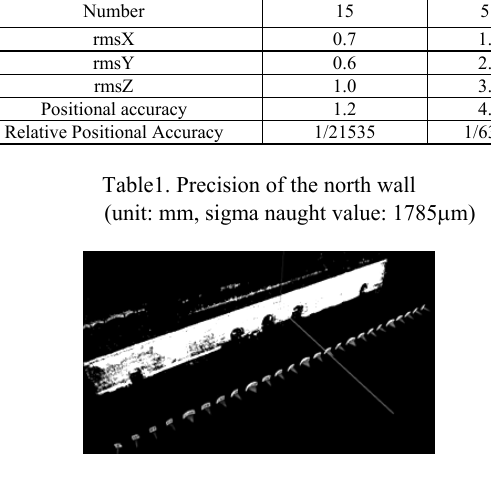
Figure7. 3D point cloud of the north